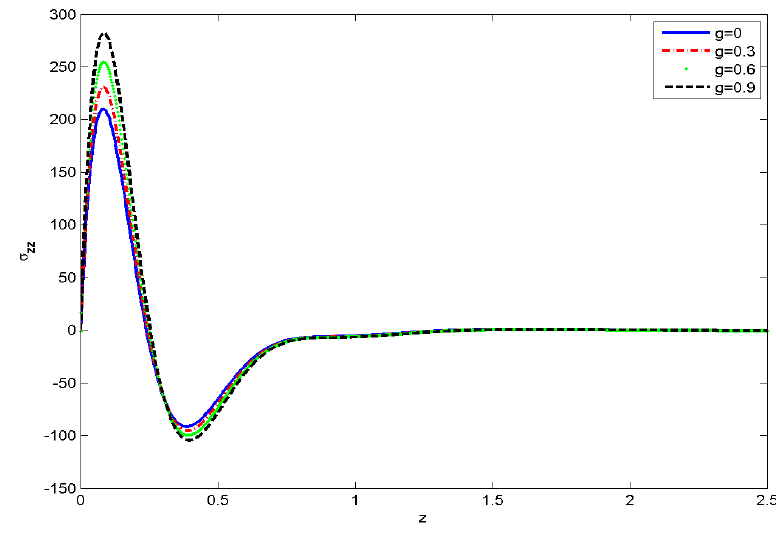
Figure 29. Normal stress σ zz concerning z with gravity g.